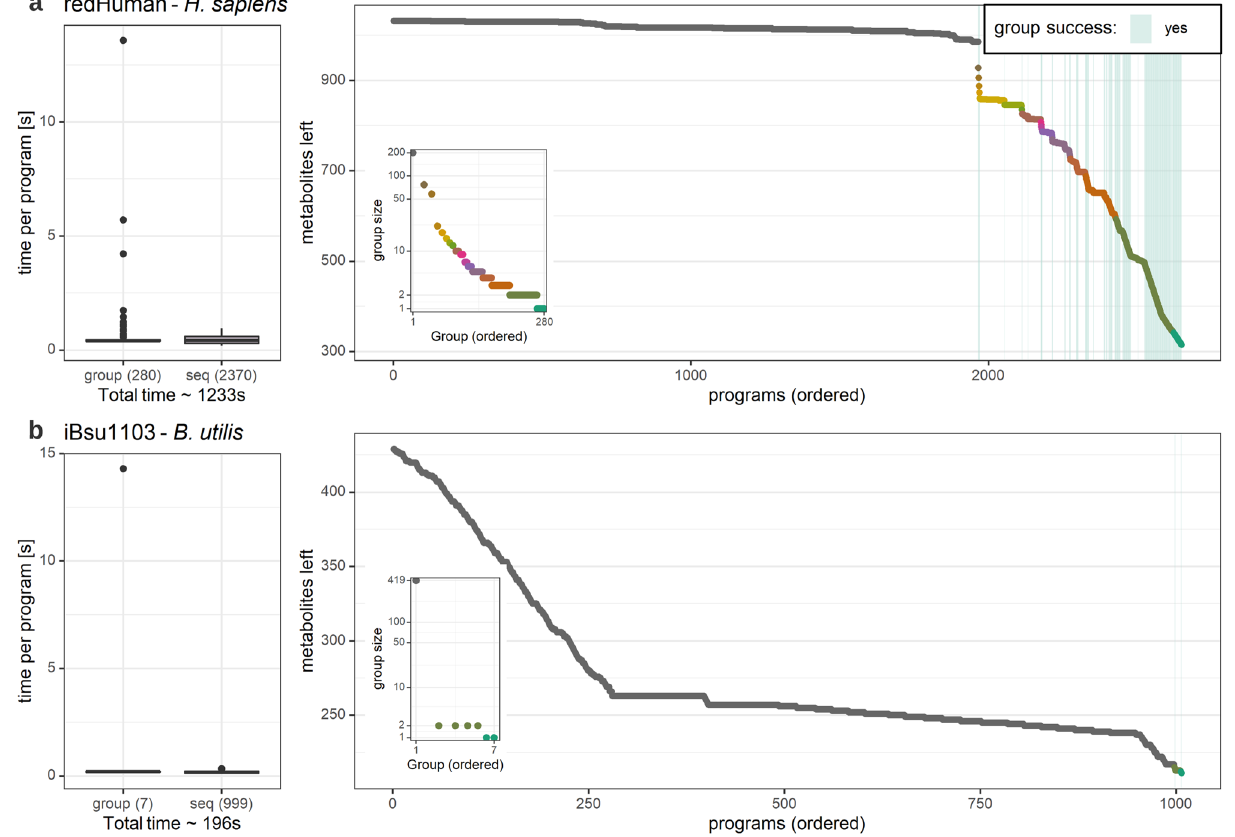
Figure 4. Analysis of time efficiency of the proposed combined procedure. The inclusion of the group procedure in the combined lumping procedure is capable to remove a group of metabolites with solving only one linear program instead of a succession of at least one program per metabolite in the group. Boxplots show the distribution of time needed per linear program separated into the group and sequential procedure with outlier (dots) displayed if the value lies beyond 1.5*IQR of respective quantile. The insets show the number of metabolites in respective group—the colours matching those in the bigger graph, which displays the progress of the lumping procedure. ( a ) During the lumping of redHuman 280 group and 2041 sequential programs were needed. The groups are ordered and coloured by their group size. If a group-program can find a solution all metabolites in respective group are removed, resulting in a sudden drop, marked here by light green lines (241 successful). Otherwise, the group program was followed by the sequential program for each metabolite in the group. ( b ) During the lumping of iBsu 7 group (4 successful) and 888 sequential programs were needed. Here, the majority of metabolites form a single group, for which respective LP does not find a solution, leading to a stepwise decrease in the number of removed